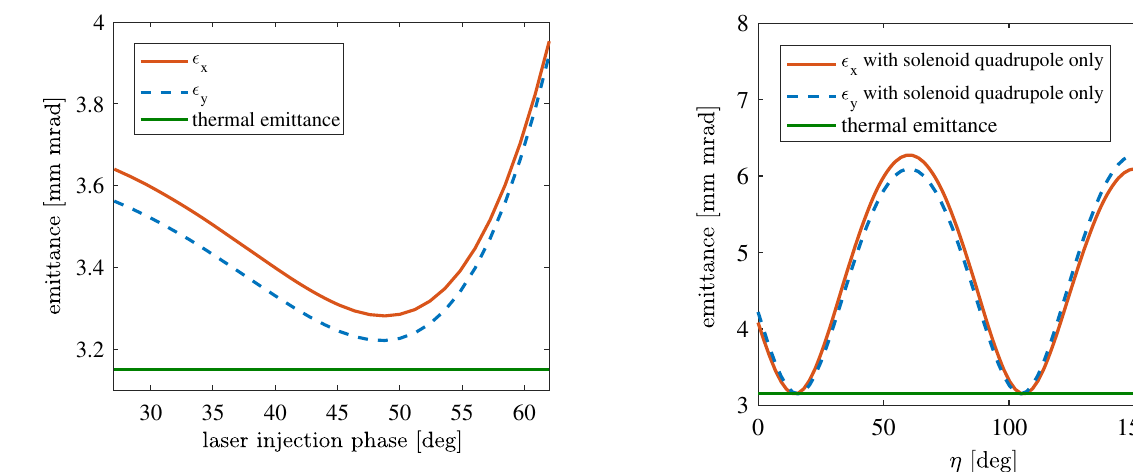
FIG. 4. Emittance at Position 2 based on the ideal rf gun (no quadrupole component) and realistic solenoid (includes quadru- pole) as a function of the rotation angle of the solenoid quadrupole.